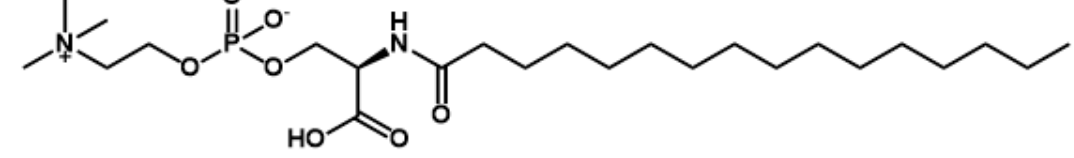
Figure 5. Speculated structure of Lyso-SM-509.